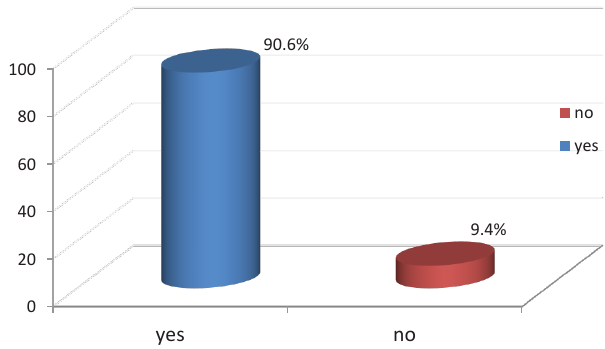
Figure 2. Perception of Importance of Vaccination Prior to Travel (n=384)